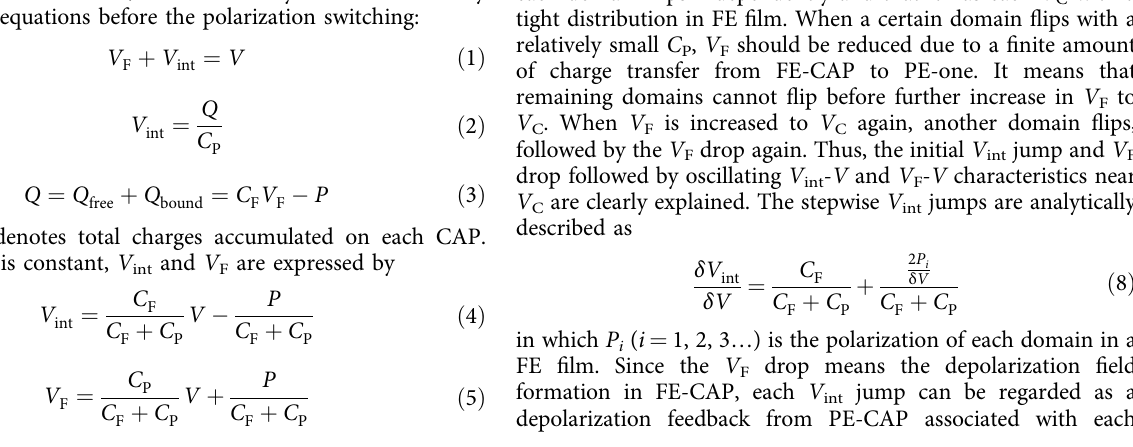
improved down to sub-60 mV dec − 1 both in forward and back- ward sweepings. δ V int / δ V GS as a function of V GS is shown in Fig. 3d. Note that the improvement factor of SS (a ratio of SS w/o to w/ FE-CAP) is roughly the same as δ V int / δ V GS in Fig. 2d. These results indicate that the steep SS value below the Boltzmann limit is de fi nitely associated with V int gain in FE/MOSFET system.